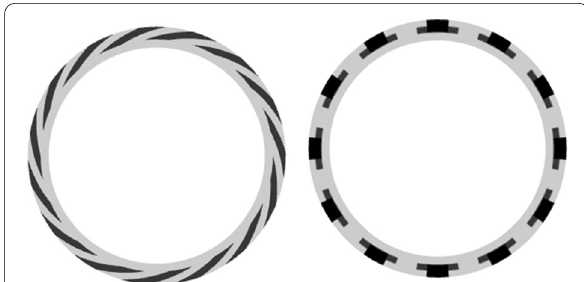
Table 7. With rotation speed and pressure fixed at 1200 r/